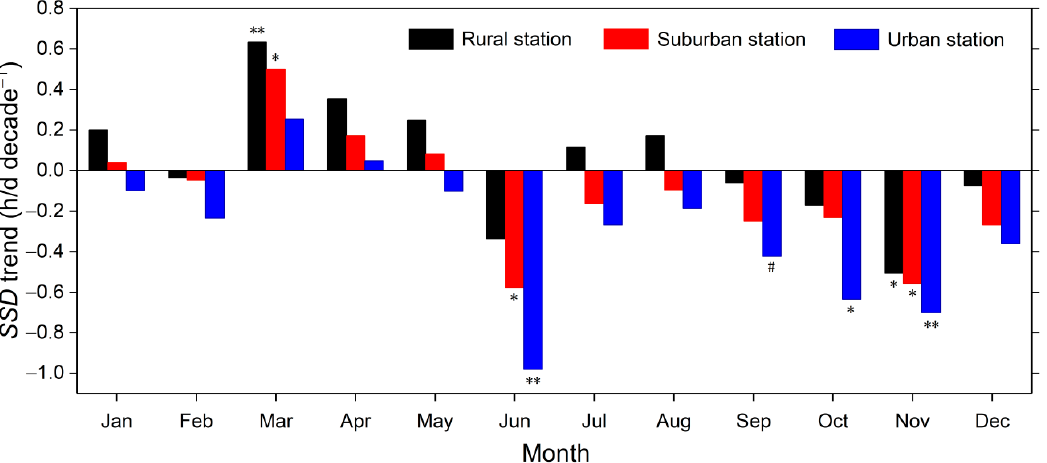
Figure 3. Change trends of monthly mean sunshine duration ( SSD ) at urban, suburban, and rural Scheme 1987. to 2016. #, *, and ** indicate that the trends are signi fi cant at the 0.10, 0.05, and 0.01 signi fi cance levels, respectively.